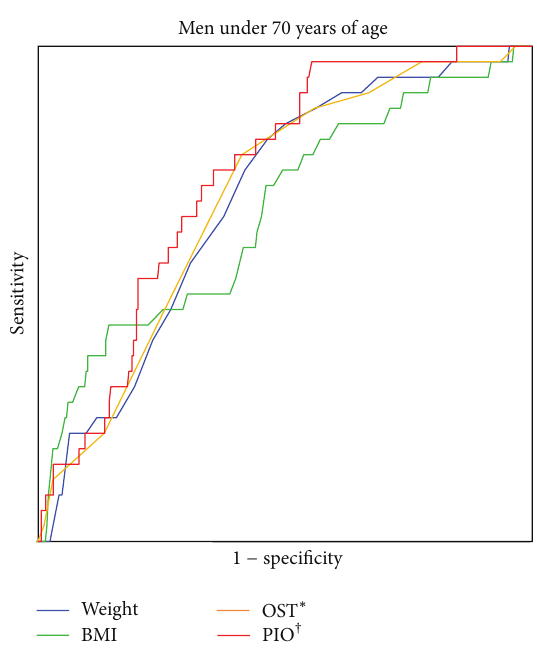
Figure 1: ROC curves of weight, BMI, OST, and PIO to identify osteoporosis in men under 70 years of age. ROC: receiver oper- ating characteristics; BMI: body mass index. ∗ Osteoporosis self- assessment tool [weight (kg) − age (years)] × 0.2, decimal dropped. † Predictive index for osteoporosis [age (years) + 10 (for current smoker)]/weight